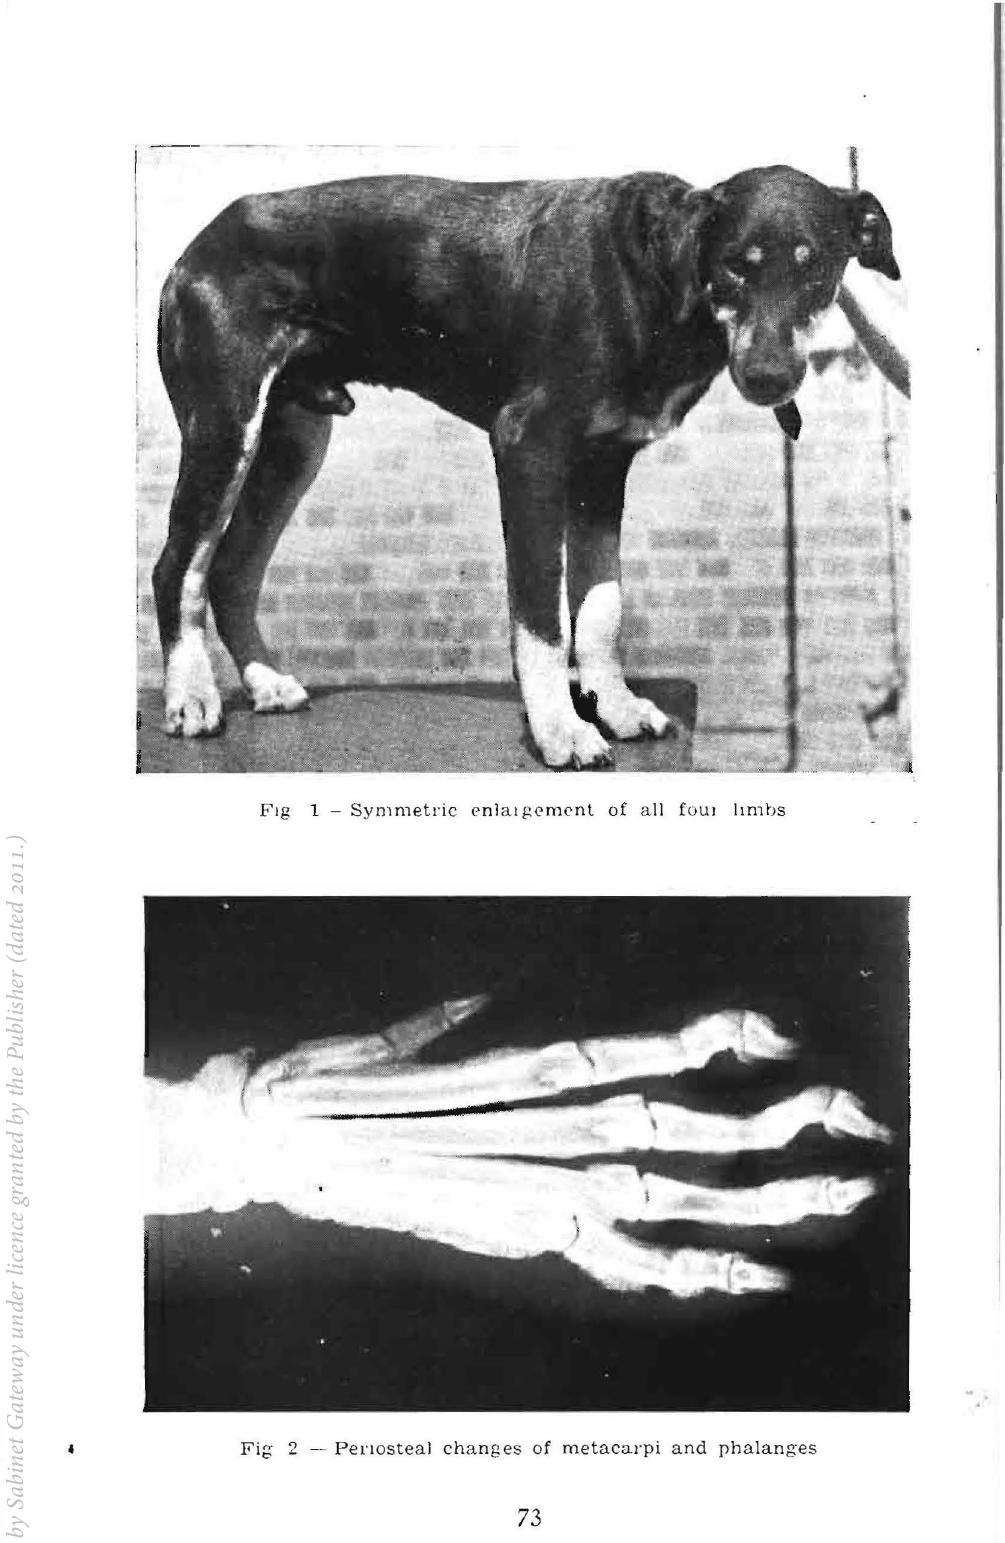
Fig- 2 -- Pel'losteal changes of metacal'pi and phalanges